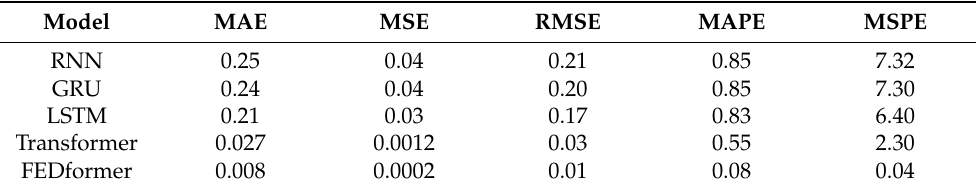
Table 4. Experimental results on the comparative performance of FEDformer-based paddy quality prediction